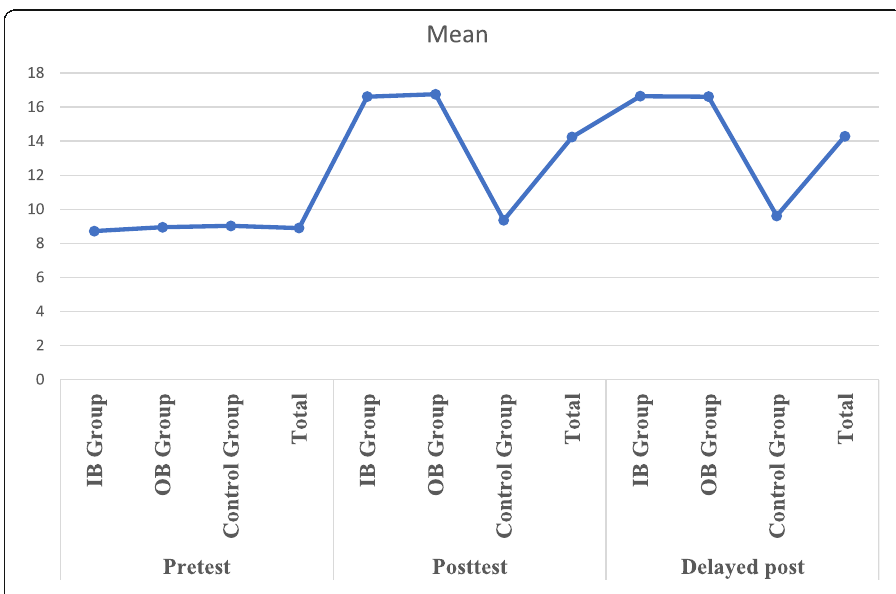
Fig. 1 Mean changes of productive vocabulary pre-test, post-test, and delayed post-test